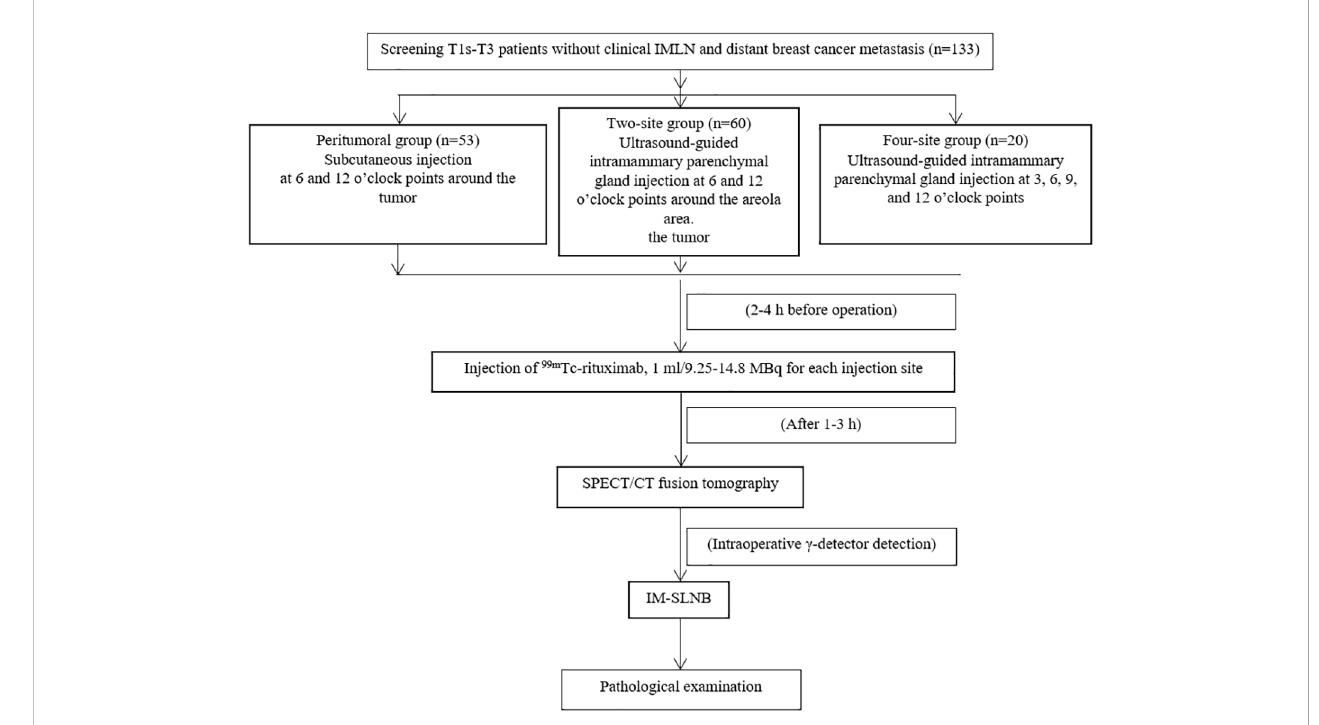
FIGURE 2 Sentinel lymph node examination process for breast cancer.